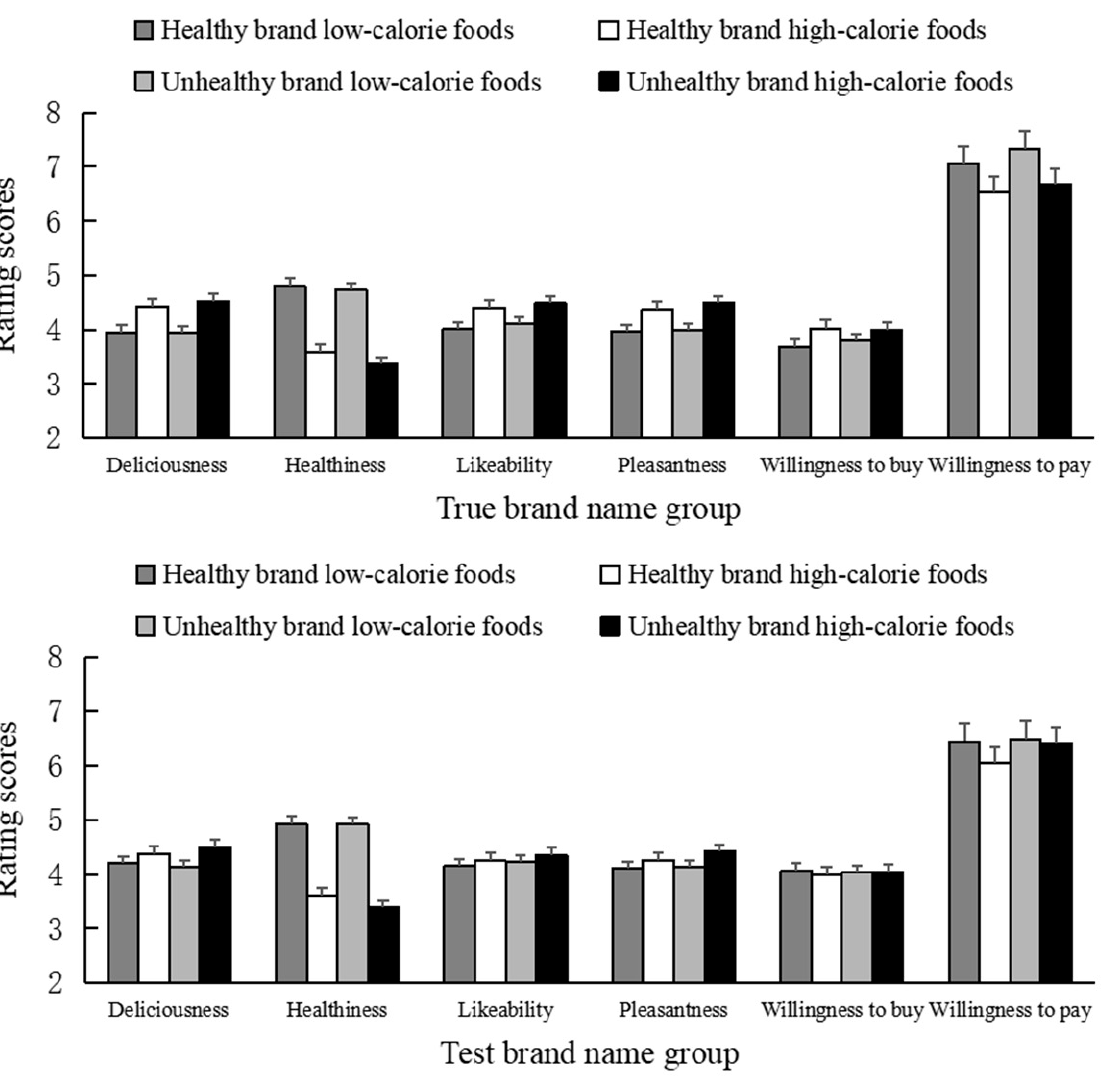
Figure 3. The mean scores of subjective ratings and purchase intention in Study 2. Error bars show the standard errors of the means.